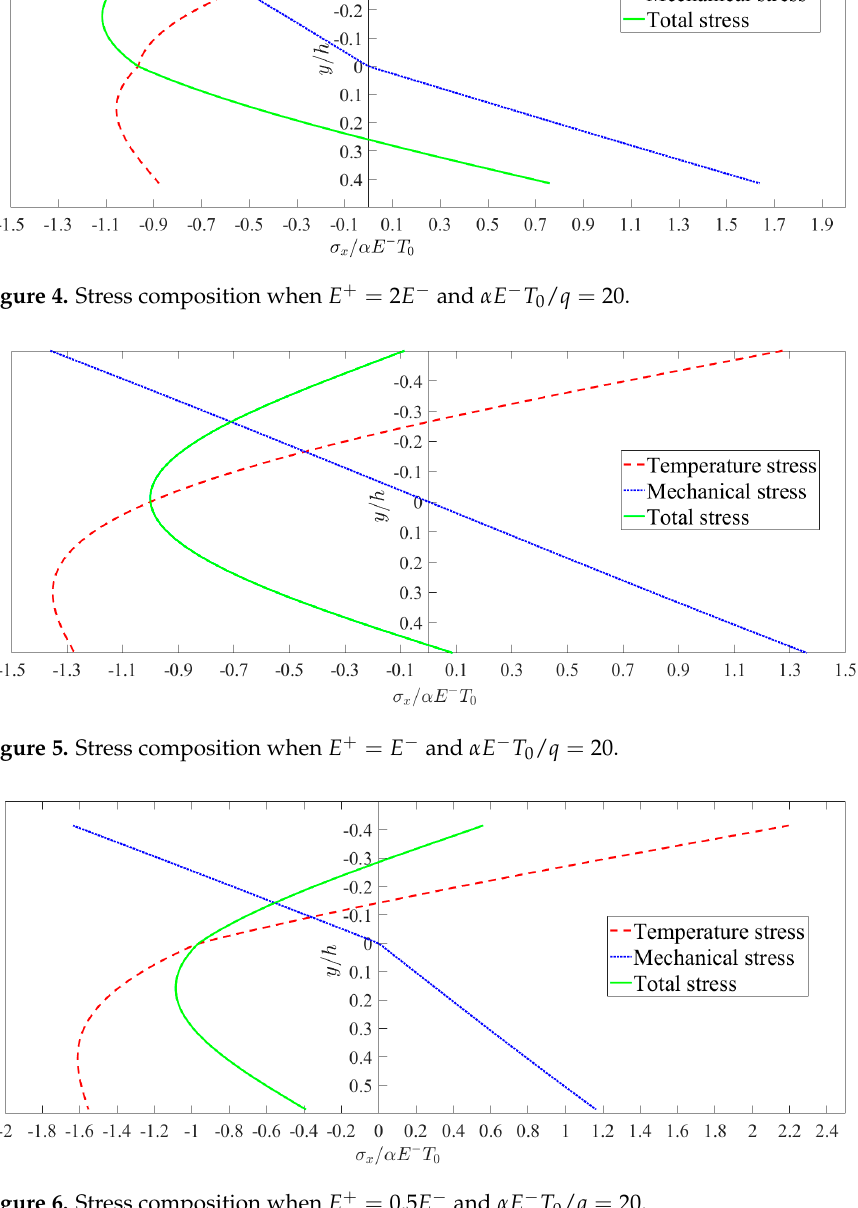
Figure 6. Stress composition when 0.5 E E